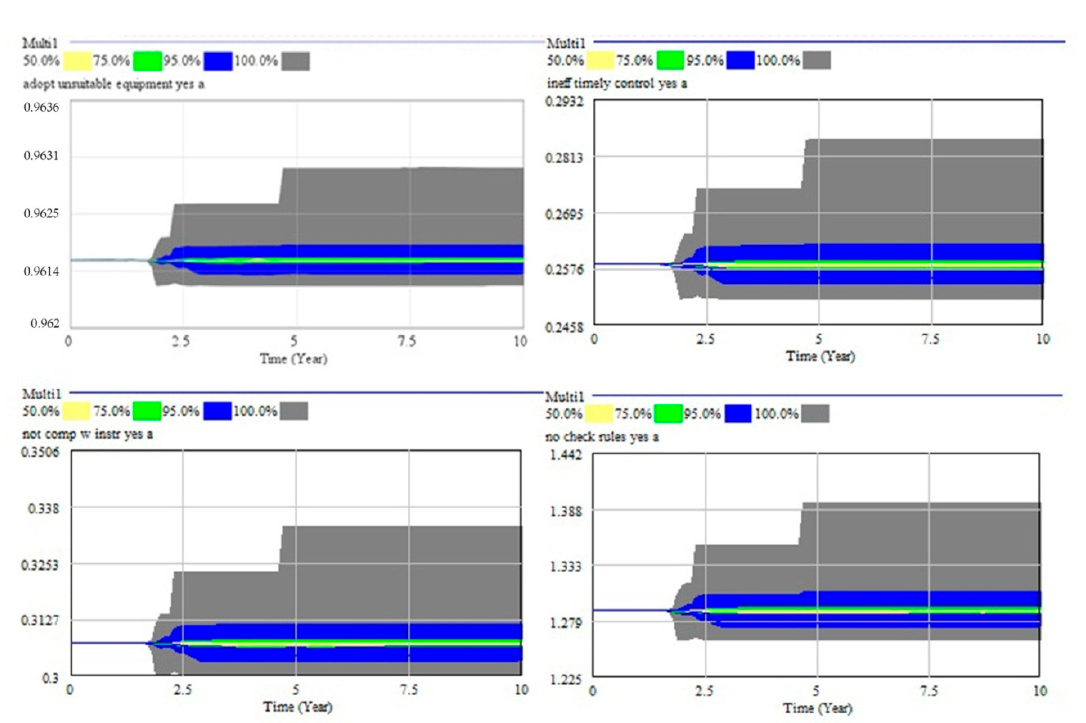
Figure 28. SD sensitivity analysis of ‘not comply with instructions’ and ‘inefficient timely control’ variables.